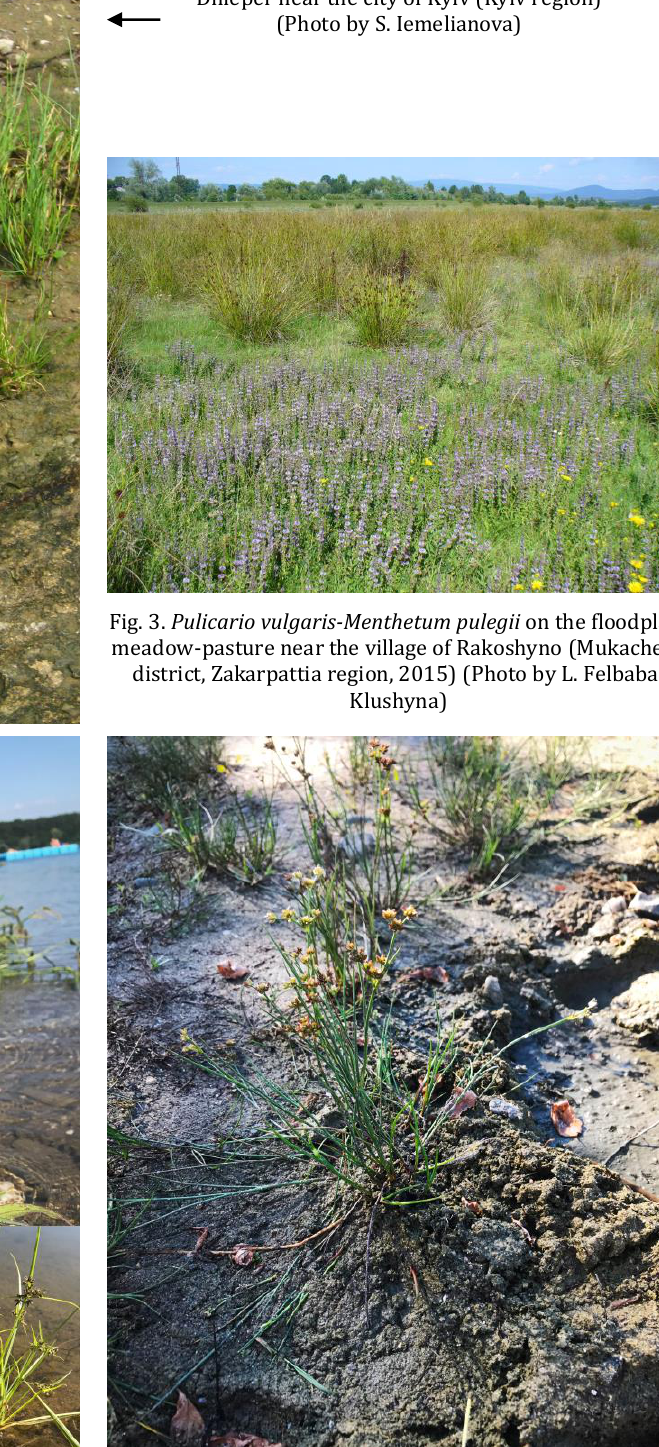
Fig. 2 . Juncetum bufonii on the littoral zone of the River Dnieper near the city of Kyiv (Kyiv region)